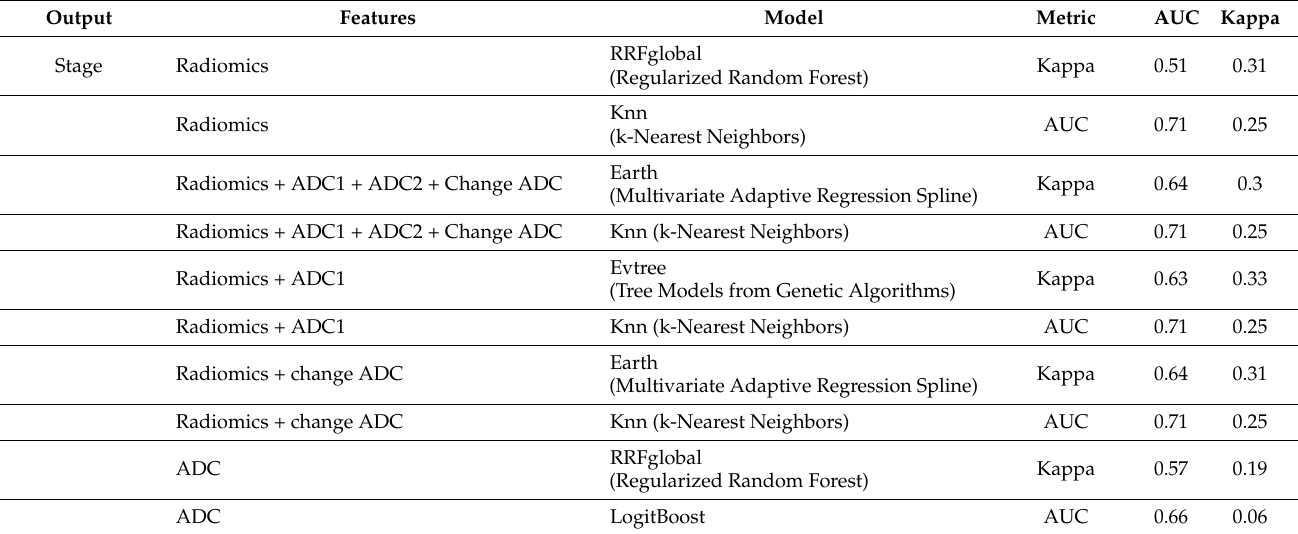
Table 4. Tabulated content of stage with relevant classifier algorithm and corresponding AUC with Kappa values. Output